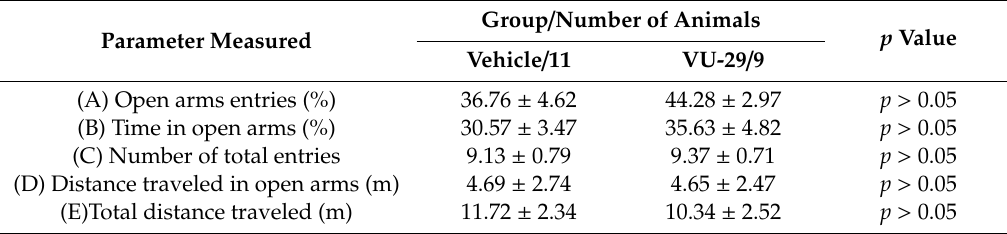
Table 6. The e ff ect of VU-29 on rat behavior in the plus-maze apparatus. The number of entries into the open arms (A), the time spent by rats in the open arms (B), the number of total entries into the both open and closed arms (C), the distance traveled in open arms (D), the total distance traveled (E). Results are expressed as mean ± SEM.